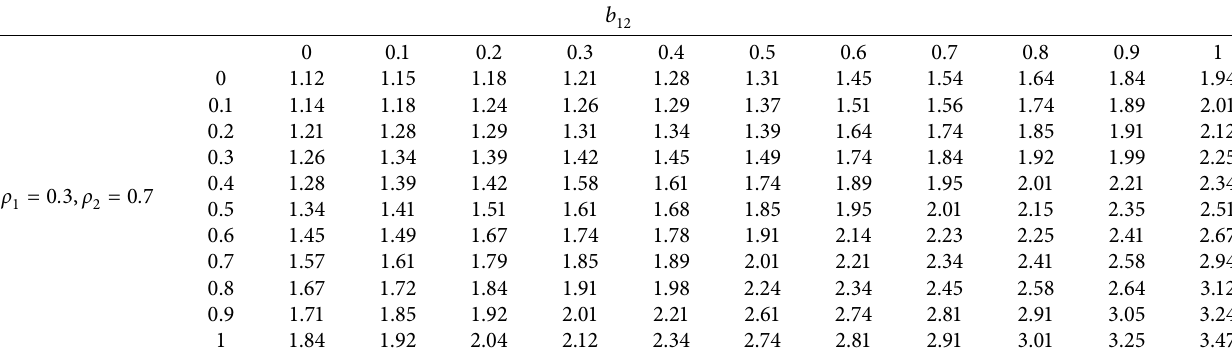
on the CFBE self + cross + market 12 retailer − 1 Table 1: The values of CFBE when. b